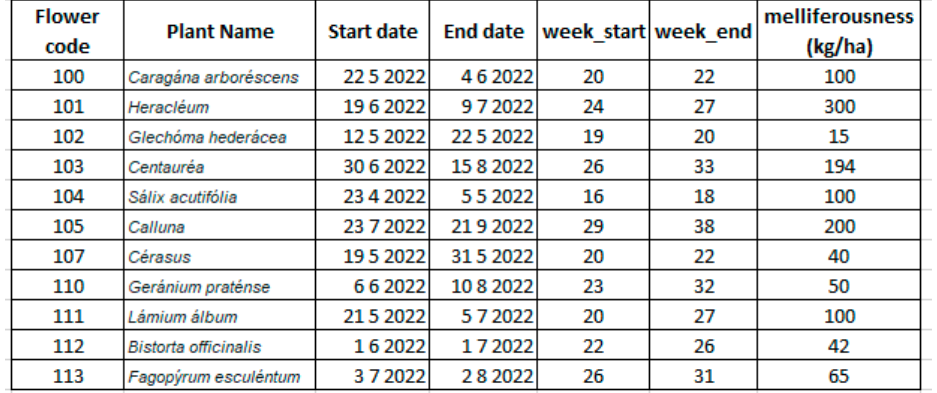
Figure 4. An example of the flowering table.